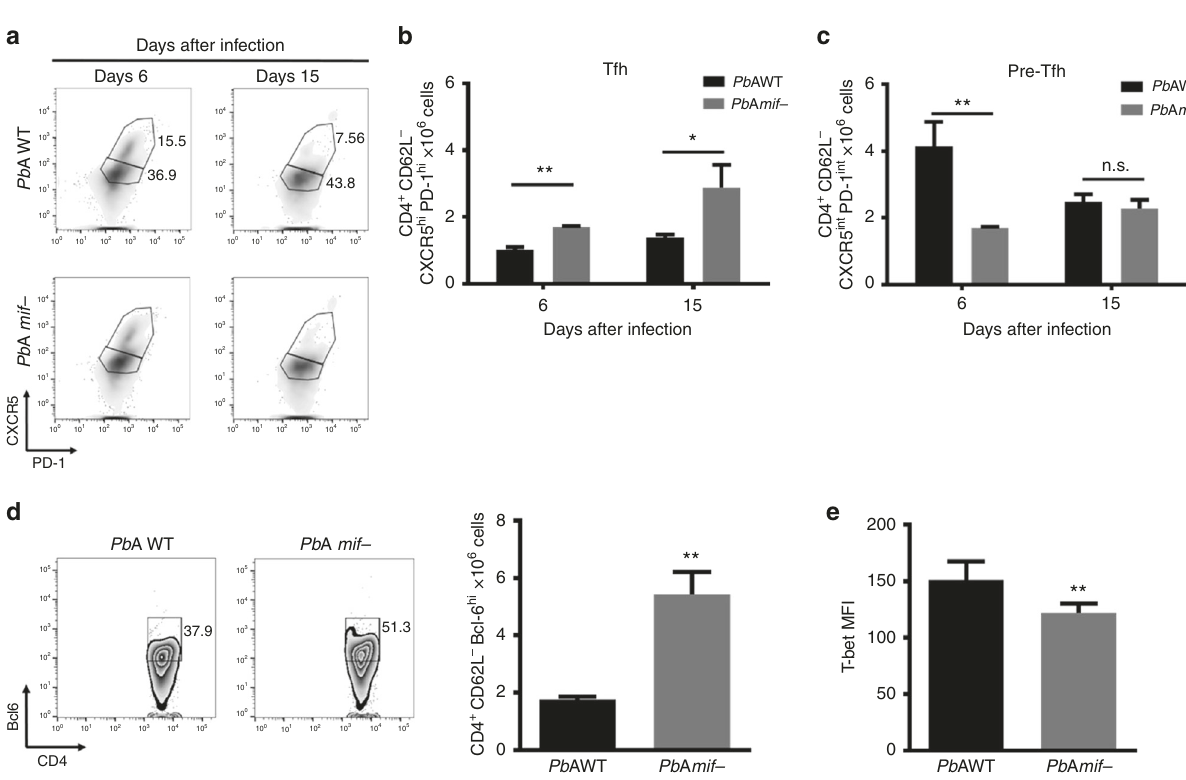
Fig. 2 PMIF inhibits Tfh cell development. BALB/cJ mice were infected with 10 6 Pb AWT or Pb A mif − iRBCs. On days 6 and 15 after infection, splenocytes were isolated and Tfh cells assessed. a – c Representative plots and absolute numbers of Tfh and pre-Tfh cells in the two groups of mice. Results are from three separate experiments. Bars represent the mean of 12 mice ± SD (* p < 0.05, ** p < 0.001 by Mann – Whitney test). d Representative plots and absolute number of CD4 + CD62L − Bcl-6 hi cells at day 6 after infection, and e expression of transcription factor T-bet in CD4 + Bcl-6 hi cells. Results are from three separate experiments. Bars represent the mean of 12 mice ± SD; * p < 0.05, ** p < 0.001 by Mann – Whitney